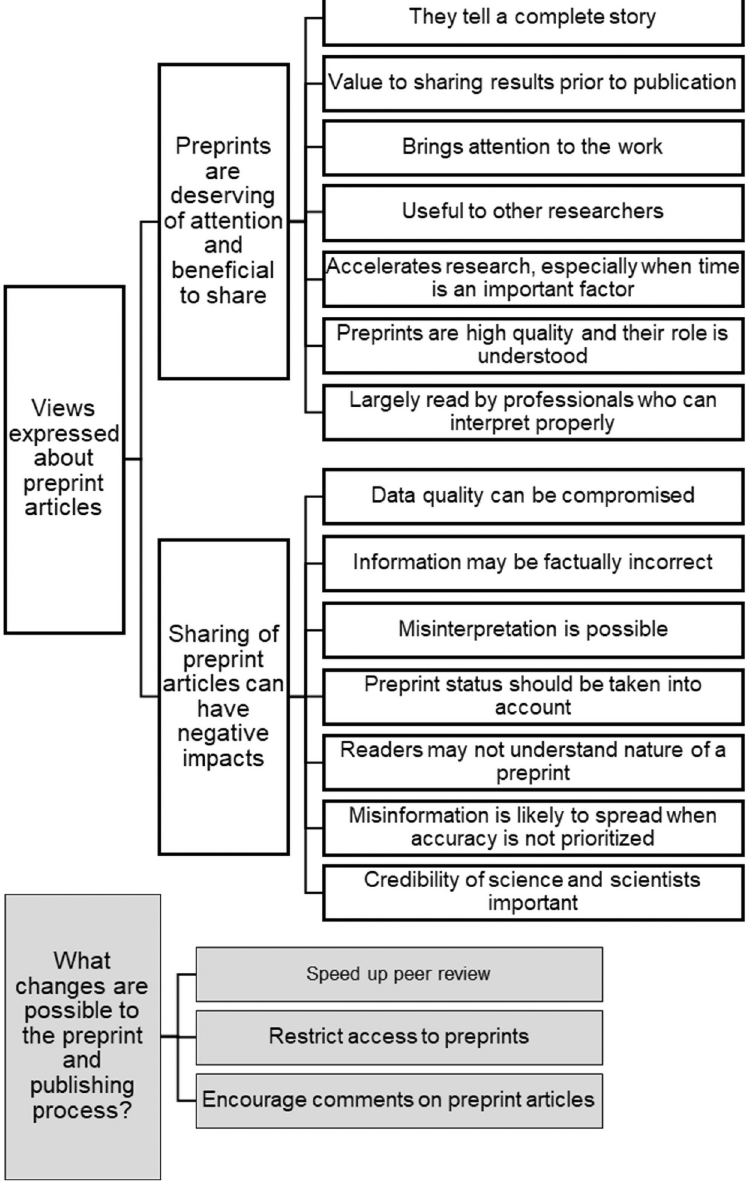
Fig 2. Student views of preprint articles and what changes could be implemented in the preprint process. Student responses to the worksheet questions of whether “preprint servers are a good way to get results out in a hurry”, whether “the [preprint] publishing process ... achieved an appropriate balance between getting research results out quickly ... versus the need for high-quality, complete, and reproducible research?” and whether “we [should]